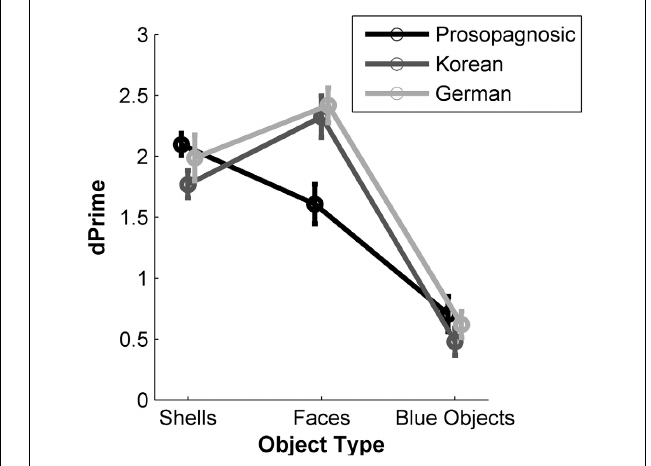
FIGURE 9 | Performance of the three participant groups in the object recognition task. Data are shown as mean d ’ values. Error bars: